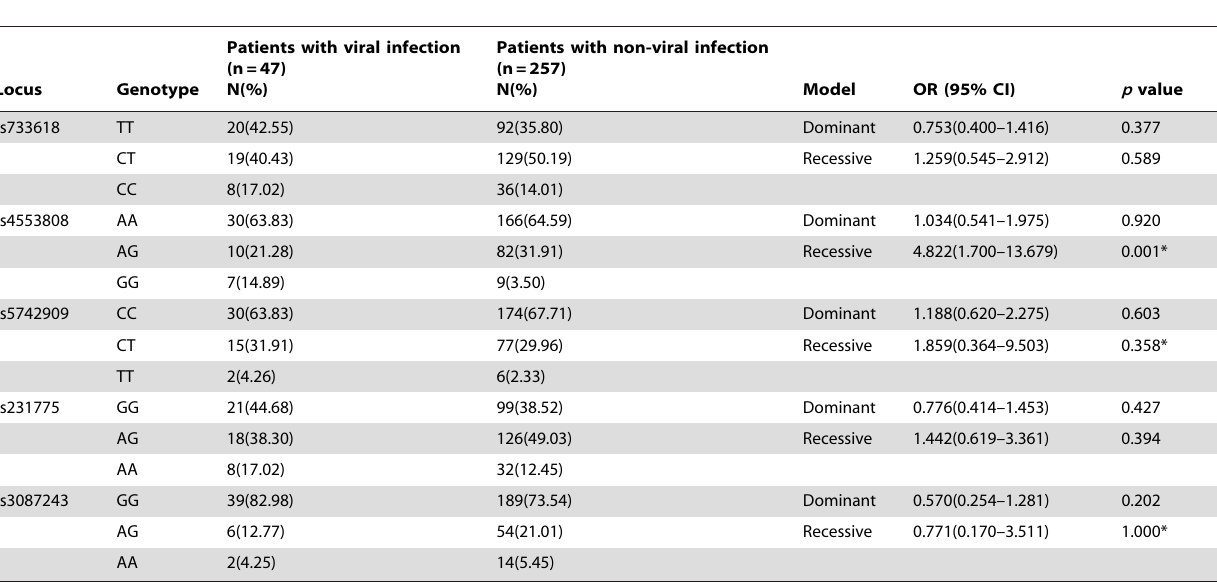
Table 3. The genotype distribution of the CTLA4 polymorphisms in patients with viral infection and non-viral infection.